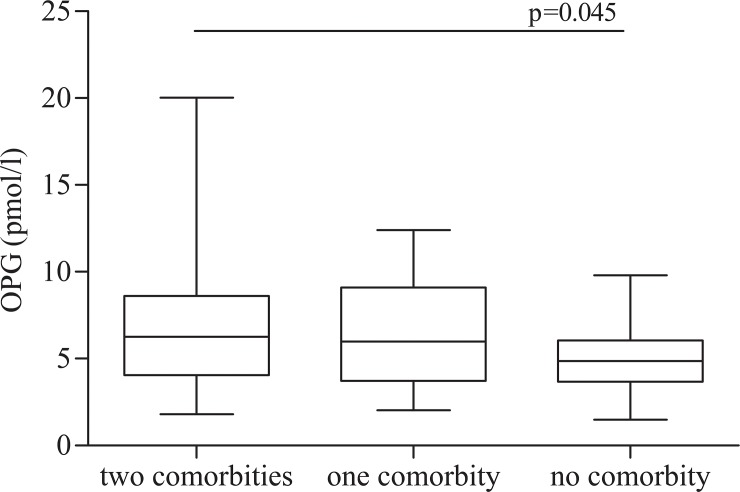
OPG plasma levels in HIV positive subjects.OPG plasma levels (pmol/l) in HIV-infected subjects according to the presence of bone and endovascular damage: presence of two comorbidties (bone and endovascular damage), only one comorbidity (bone or endovascular damage), no comorbidity. The horizontal bars represent median. The upper and lower whisker indicate the third quartile +1.5 [Inter Quartile Range (IQR)] and first quartile -1.5(IQR).